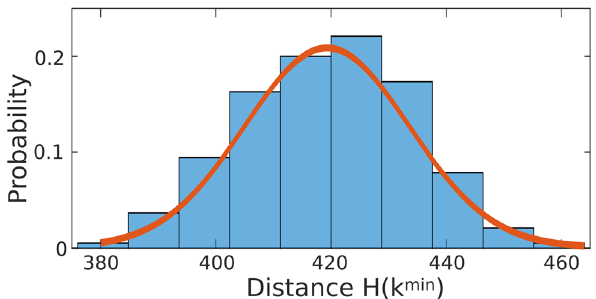
Figure3: ProbabilitydistributionoftheHammingdistancesat k = N , obtained from the different greedy learning curves displayed in Figure2a.Redcurveis aGaussian fi twhichiscentredat 419andhas a standard deviation of 29.